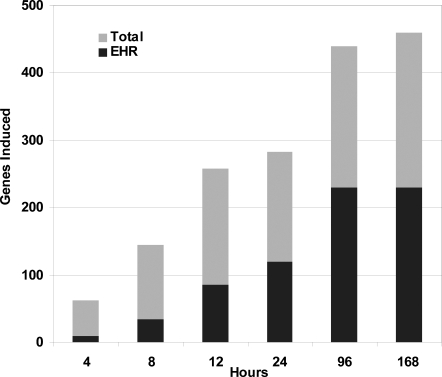
Enduring hypoxic response (EHR) dominates the hypoxic time course.Numbers of genes significantly induced over log phase (>two fold, FDR<0.4%) were tabulated at each time point over a hypoxic time course. Each bar represents the total number of genes (gray) and genes from the EHR (black).